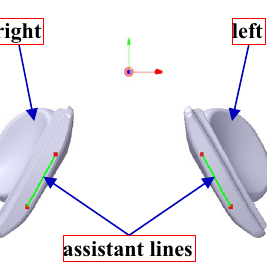
assistant lines Figure 17. The assistant lines of the nose